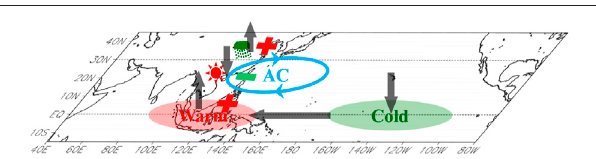
FIGURE 8 | Schematic diagram illustrating the in fl uences of SSTA and atmosphere circulation anomalies on summer rainfall over the YHRV in P1 positive years. Red and green shaded areas indicate warm and cold SSTA respectively. Blue arrow indicates the WPSH. Vertical grey arrows indicate updrafts and downdrafts. Horizontal grey arrow indicates the equator easterly wind. “ Red plus-green minus-red plus ” indicates the PJ pattern, where plus and minus represent positive and negative vorticity centers,